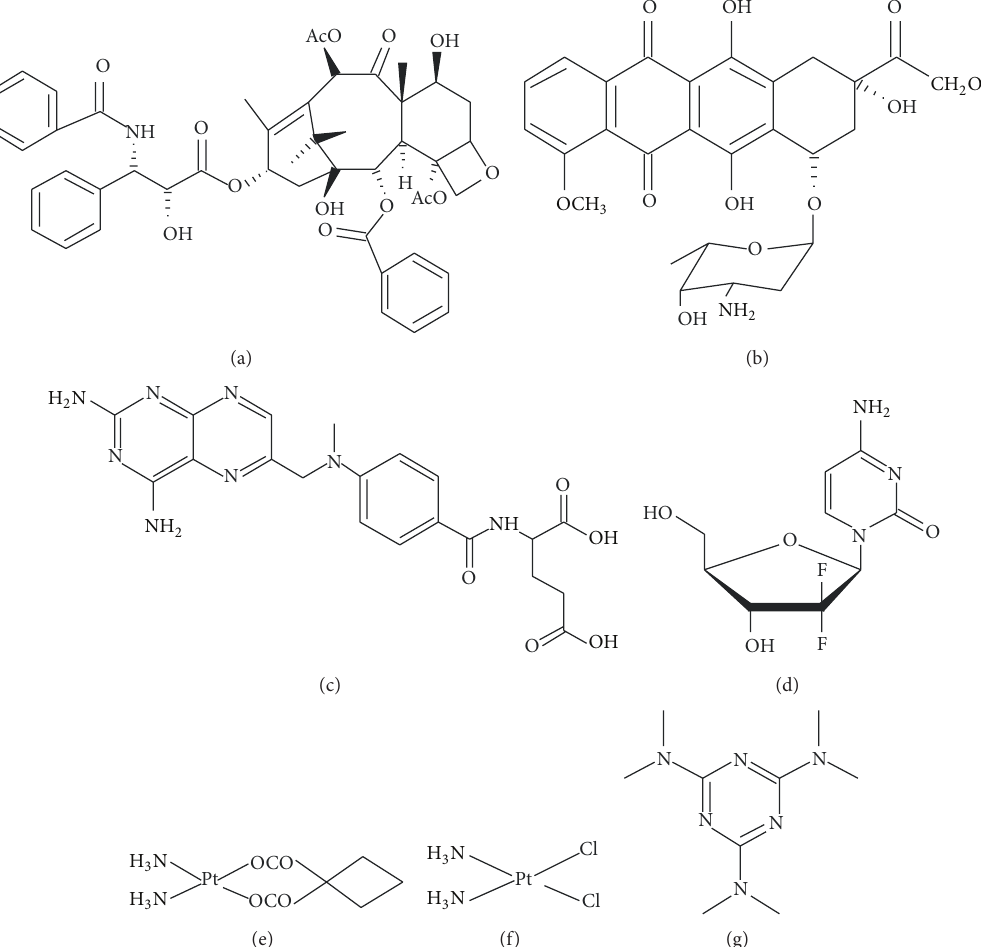
Figure 2: Chemical structures of drugs: (a) paclitaxel, (b) doxorubicin, (c) methotrexate, (d) gemcitabine, (e) carboplatin, (f) cisplatin, and (g)